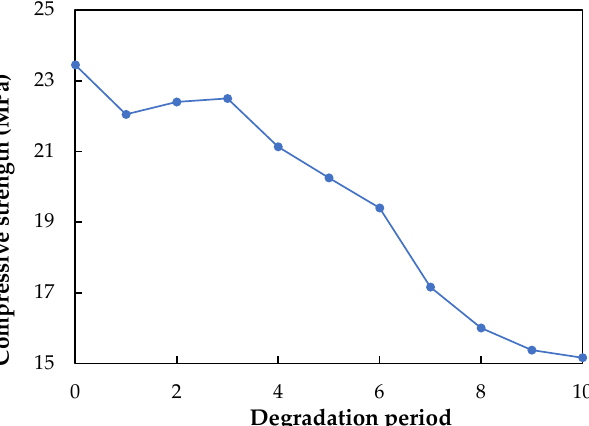
Figure 6. Compressive strengths of concrete core samples in 0–10 degradation periods.